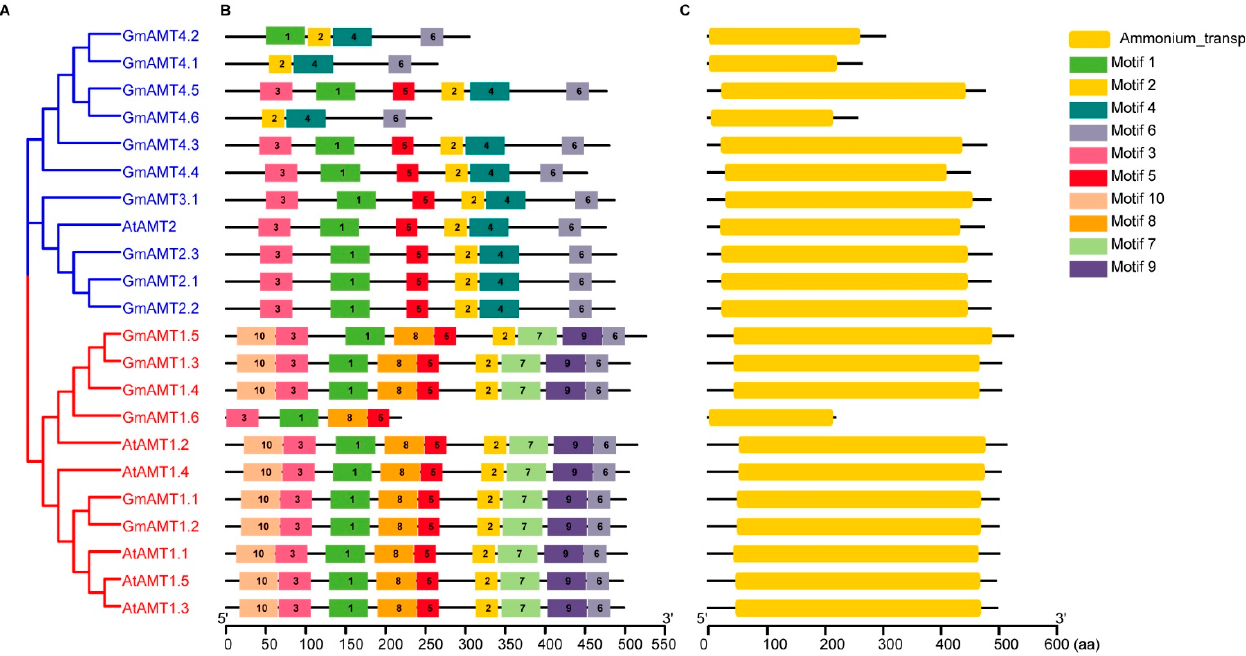
Figure 1. Conserved protein motifs and conserved domain analysis of AMTs in soybean and Arabidopsis . ( A ) An unrooted phylogenetic tree was constructed by MEGA X software using the maximum-likelihood method. The blue and red branches represent the AMT2 and AMT1 subfamilies, respectively. ( B ) Conserved motif analysis of AMT amino acid sequences by the MEME online website. Different colors represent different motifs. ( C ) Conserved domain analysis of AMT proteins by the NCBI CD-search